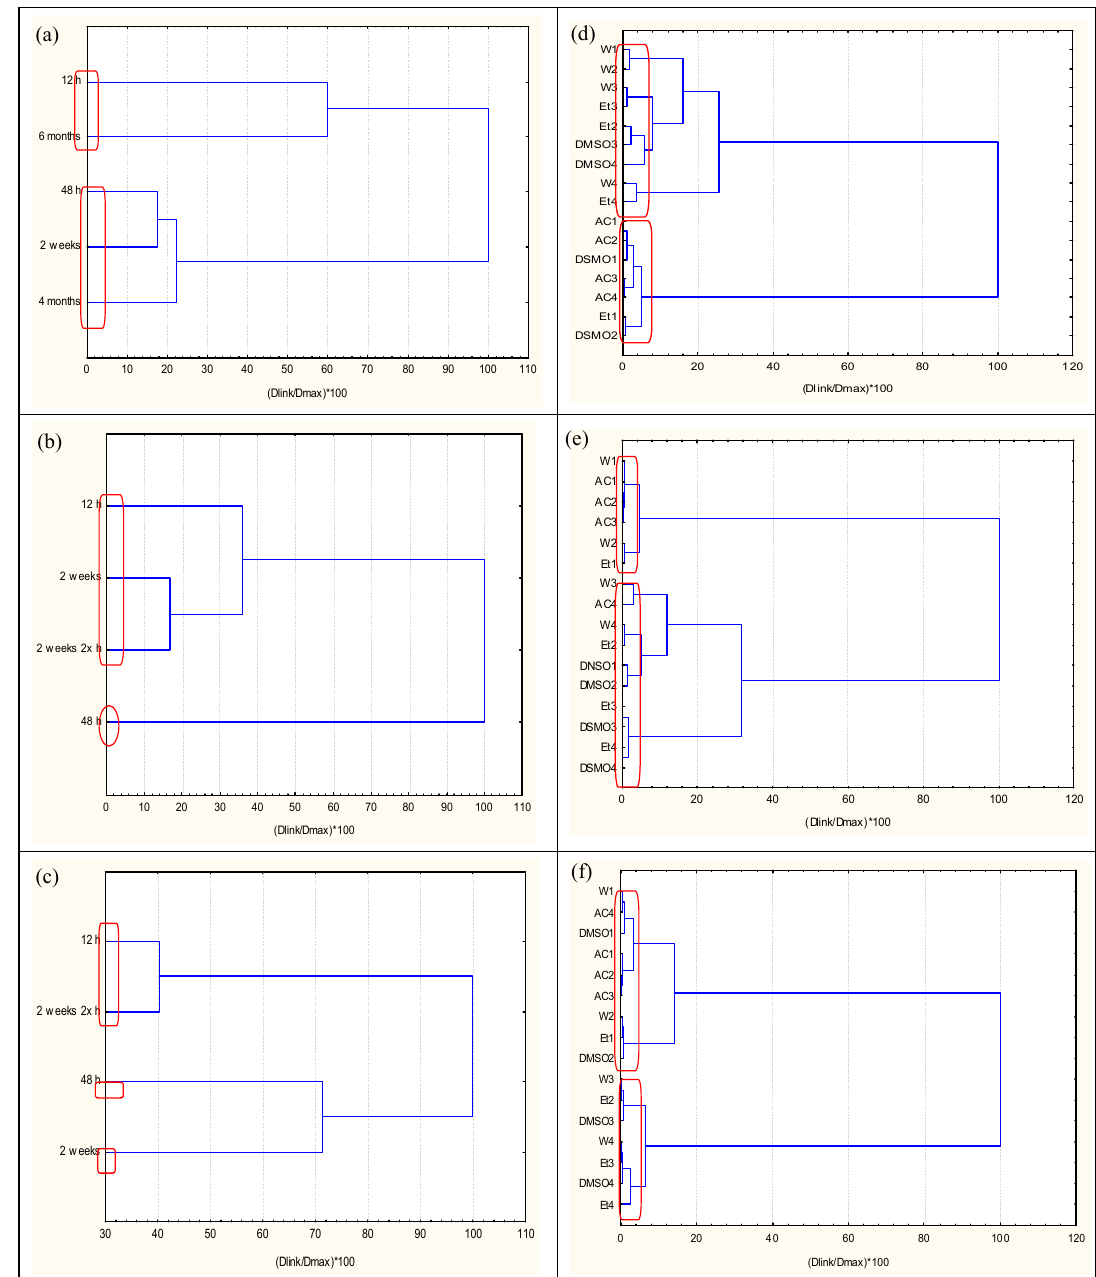
Figure 1. Hierarchical dendrogram for clustering of: ( a ) variable–time of extraction (RT data), ( b ) variable–time of extraction (65 °C), ( c ) variable–time of stay (121 °C data), ( d ) objects–extraction media (RT data), ( e ) objects–extraction media (65 °C data), ( f ) objects–extraction media (121 °C).